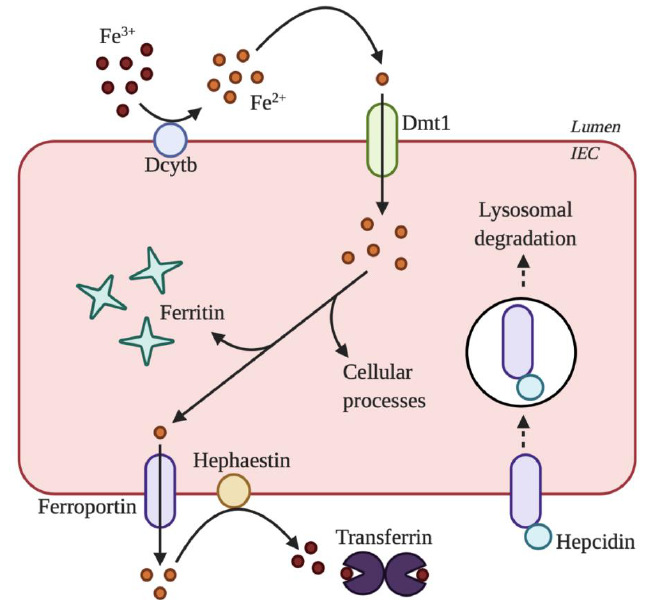
Figure 1. Absorption of nonheme iron by intestinal epithelial cells (IECs). Ferric iron is first reduced to ferrous iron by duodenal cytochrome B (Dcytb) on the apical membrane. Then, ferrous iron is transported across the apical membrane by divalent metal transporter 1 (DMT1). Once inside the cell,